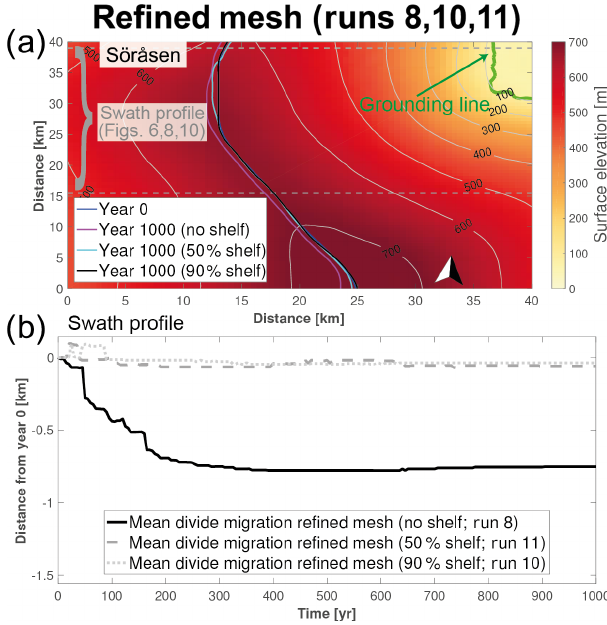
Figure 10. (a, b) Ice-rise divide migration for the Söråsen Ice Rise induced by different ocean perturbations (shelf removal, 50% ice- shelf thickness, and 90% ice-shelf thickness) for the refined mesh. (a) shows divide positions at the end of the simulation period. (b) shows mean divide migration for the different perturbations. Negative numbers indicate migration to the